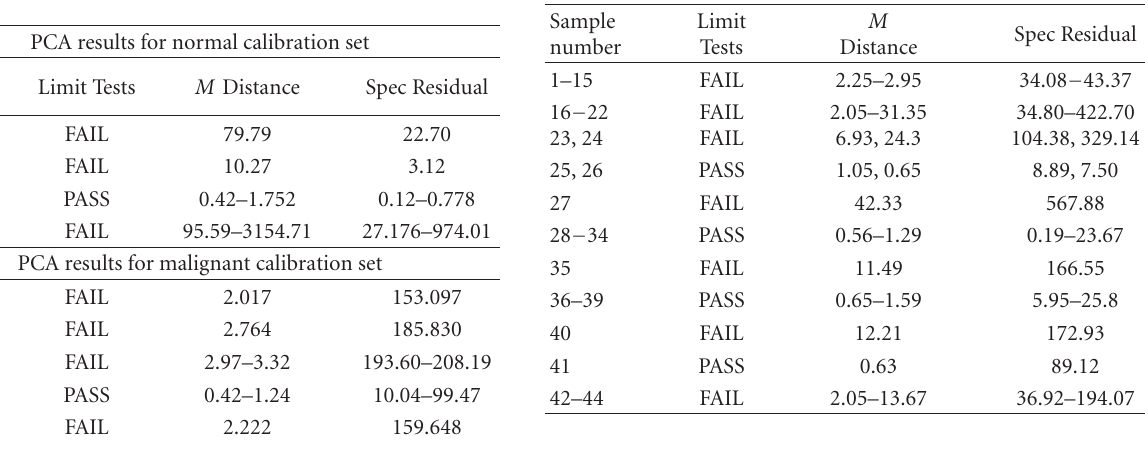
Table 3: Discriminate analysis with standard stage III